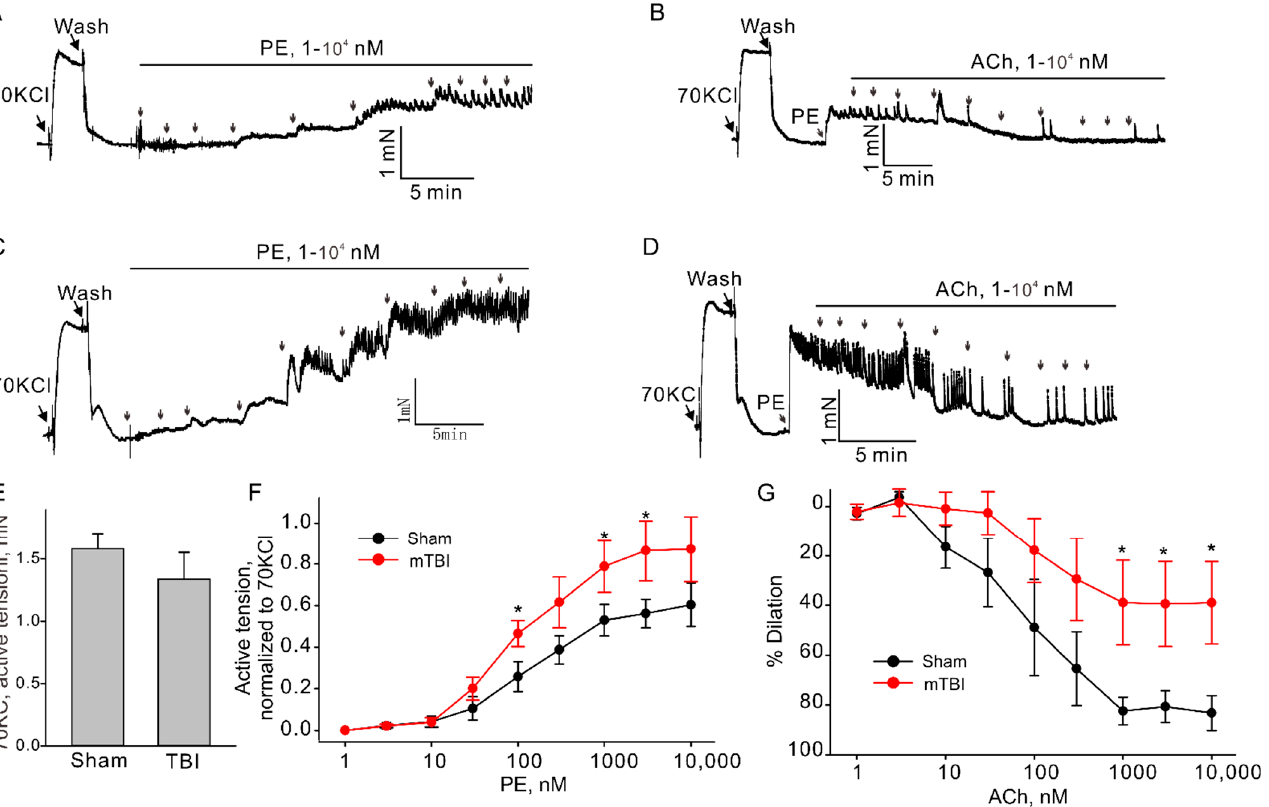
Figure 5. Effect of mTBI on endothelial function in mouse aortic arches 2 h after mTBI. ( A , C ). The representative traces of active tension changes in sham and mTBI mice induced by phenylephrine (PE). ( B , D ). The representative traces of aortic dilation induced by acetylcholine (ACh) in sham and mTBI mice. ( E ). Statistical graphs comparing the active tensions-induced by 70 mM KCl. ( F ). Concentration-response relationships for PE-induced contractions in aortic arch rings from sham and mTBI mice. ( G ). Concentration-response relationships for Ach-induced dilation. Data are presented as mean ± SEM, * p < 0.05 compared to sham.